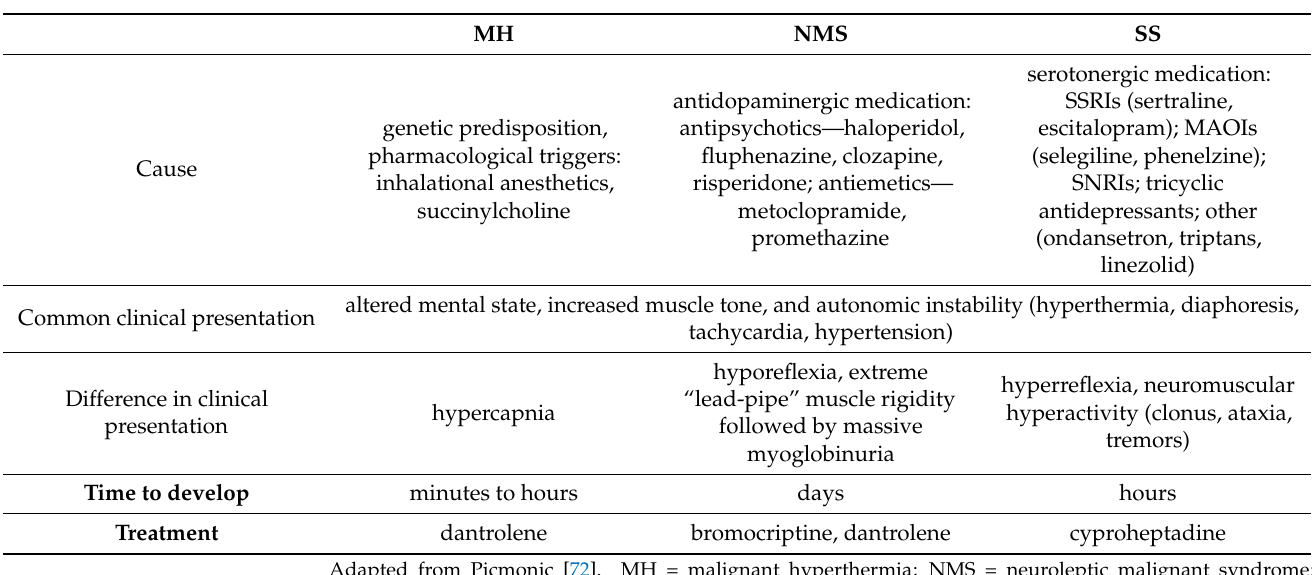
Table 2. Malignant hyperthermia vs. Neuroleptic malignant syndrome vs. Serotonin